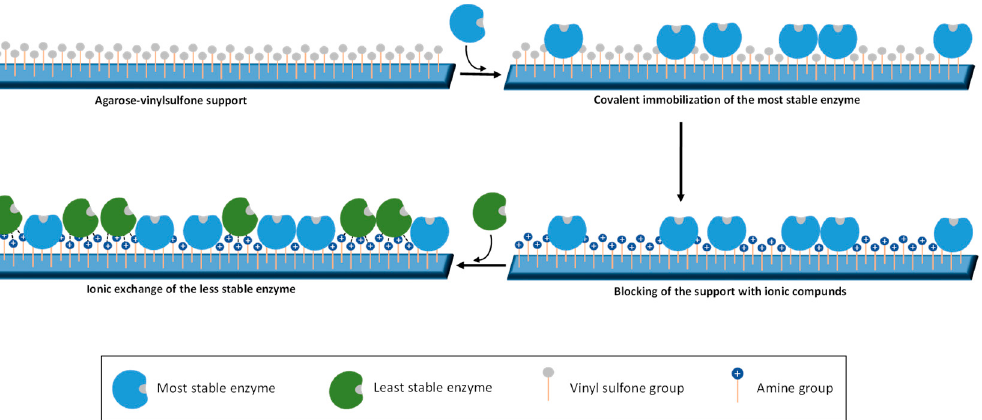
Figure 12. Use of vinyl-sulfone activated support to prepare combi-biocatalysts that enable the reuse of the most stable enzyme after the least stable enzyme inactivation. The most stable enzyme is covalently immobilized in the vinyl-sulfone groups. The support is blocked with ionic compounds, and the least stable enzyme is immobilized solely via ionic exchange. After inactivating the least stable enzyme, it may be released by incubation at high ion strength. The more stable enzyme may be reused to build a new combi-biocatalyst.